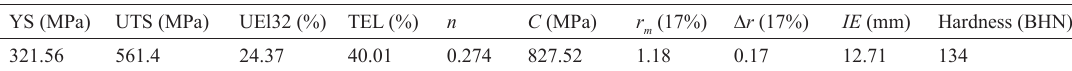
Figure 5: Typical micrographs (OM) of Al-killed AISI 1020 steel strips after, a-b) hot rolling, and c-d) heat treatment. Table 3. Mechanical properties of the steel after heat